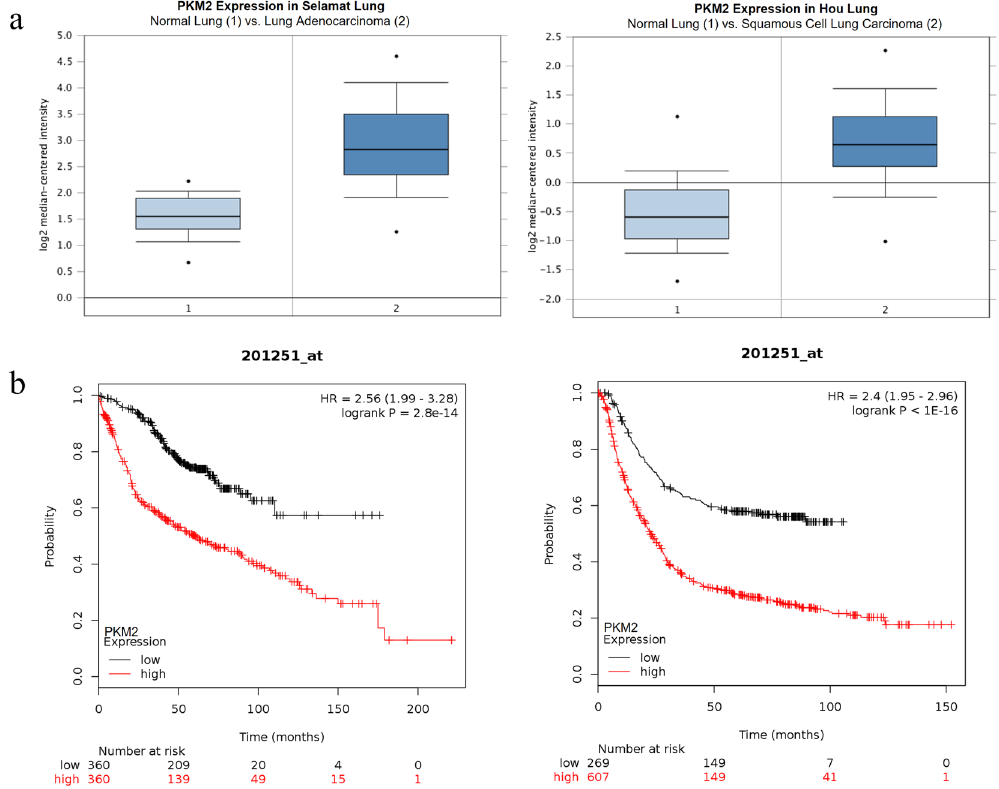
Figure 6. PKM2 expression is high in cancer and correlates with poor overall survival. ( a ) Box plots from Oncomine representing the higher PKM2 expression in lung adenocarcinoma and squamous cell lung carcinoma, compared to normal lung. ( b ) Kaplan-Meier overall survival (OS) curve of patients with lung cancer expressing low and high PKM2 mRNA. (PKM2 low expression group, n = 360; PKM2 high expression group, n = 360) and Kaplan-Meier overall survival (OS) curve of patients with gastric cancer expressing low and high PKM2 mRNA. (PKM2 low expression group, n = 269; PKM2 high expression group, n =